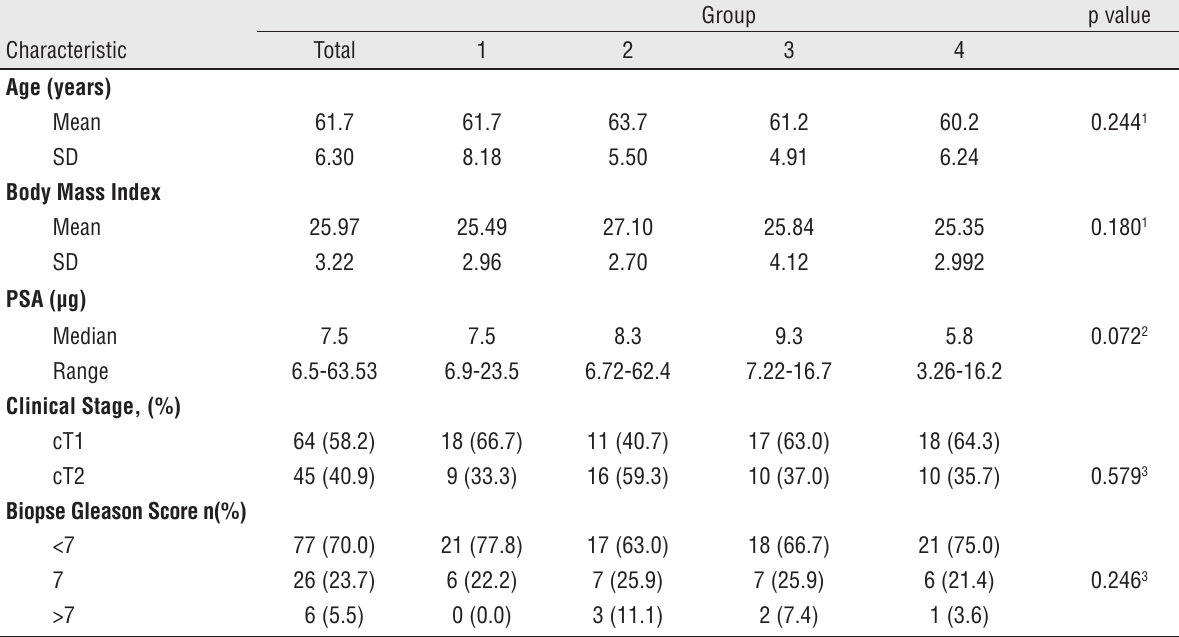
Table 1 – Demographic and Clinical